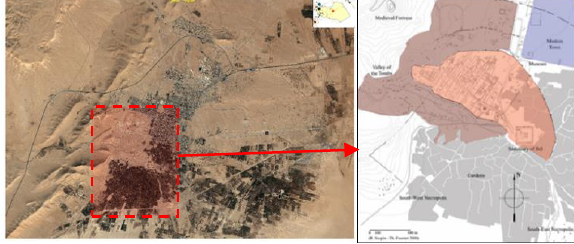
Figure (2-3) Site plan of Palmyra and the modern city GIS/